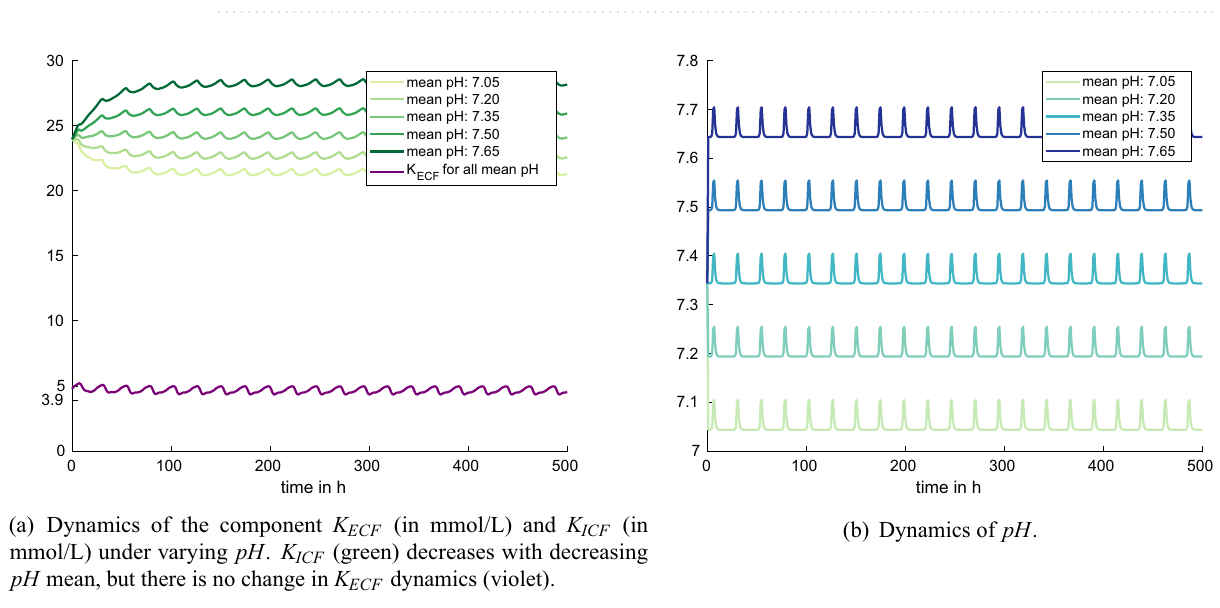
(b) Dynamics of pH .